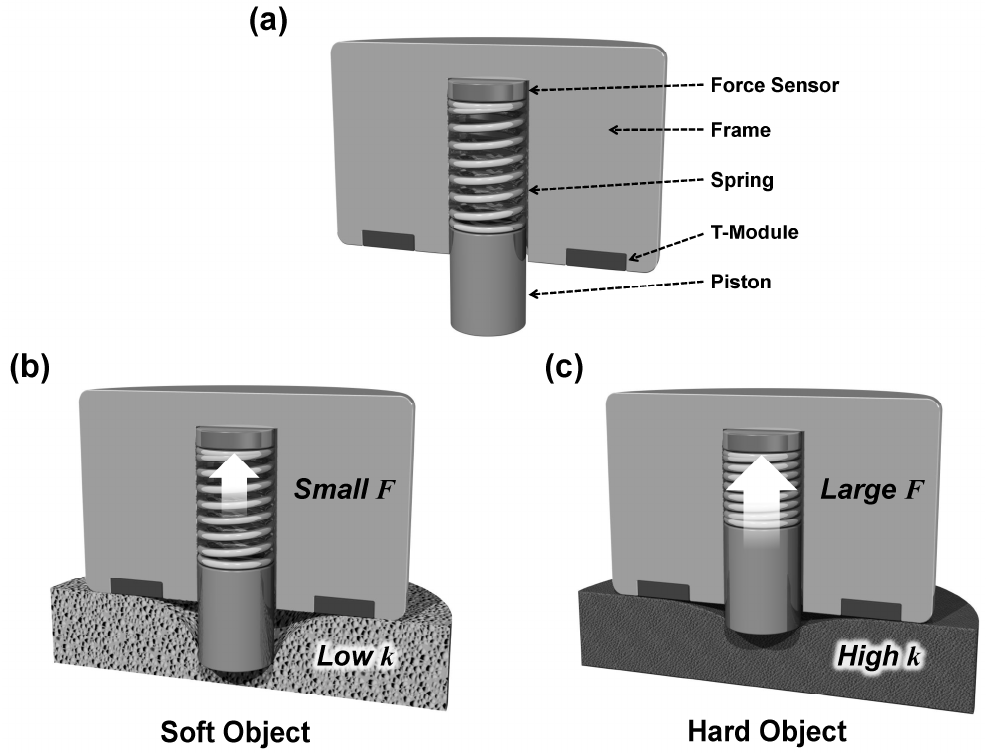
Figure 1. Schematic illustration of the stiffness measurement system. ( a ) Cross-sectional schematic diagram of the initial state of the stiffness measurement system. Comparison between measurements of ( b ) soft and ( c ) hard objects.